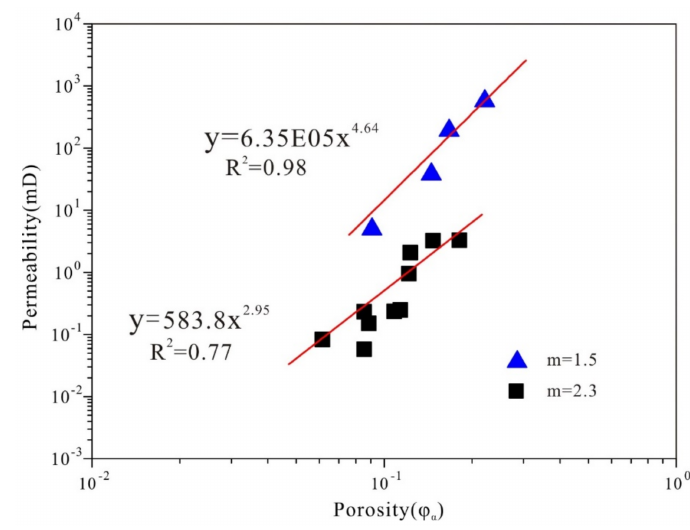
Figure 9. Permeability vs. porosity for coal samples (square point) and other rocks (triangle